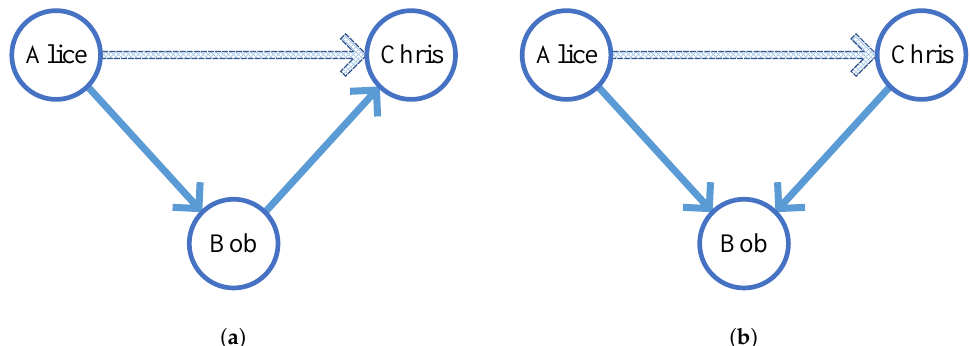
Figure 1. Two primary trust propagation strategies. ( a ) Direct trust propagation. ( b ) Transposed trust